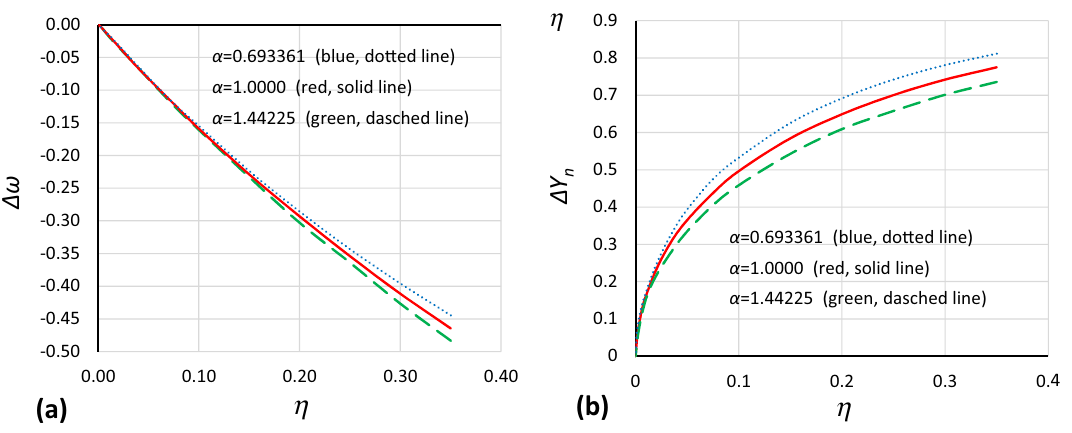
Figure 15. Changes in the position of the origin point P B due to damping for curves with nondimensional values Y n . Changes in frequency ( a ) and Y n displacement ( b